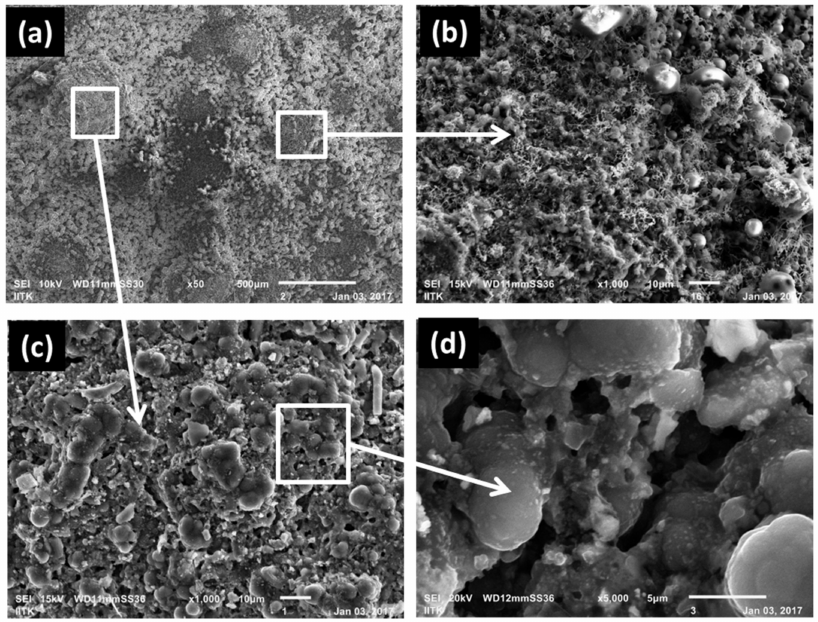
Figure 5. Surface morphology of the ablated specimens: ( a ) SEM image of the as-ablated specimen; ( b , c ) magnified image at two different locations showing different surface morphologies; ( d ) solidified network of the molten oxide phases of TaC and